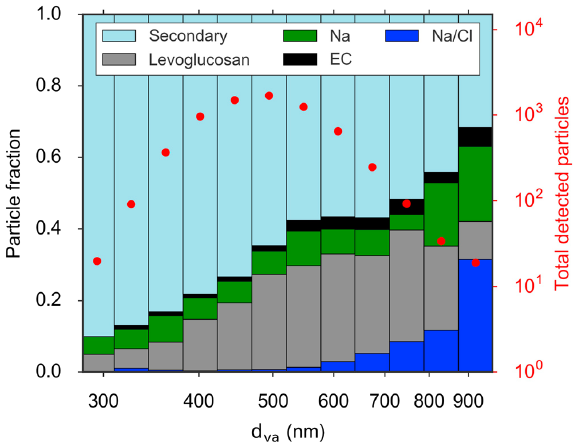
Figure 10. Time series of measured and modelled numbers of par- ticles 10nm and larger at Alert during 2011. Seabird ammonia is included in the blue curve simulation but not in the red curve simu- lation. Measurements are in black. Figure from Croft et al. (2016a). GCT represents